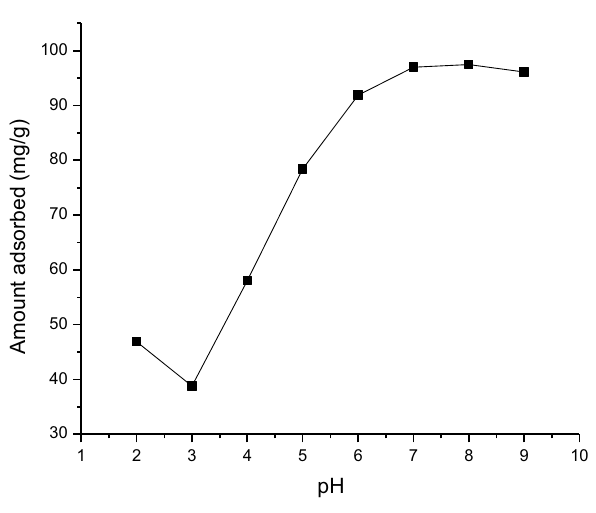
Fig. 6 Effect of adsorbent mass on adsorption of Pb 2+ ions on WM- Fe 3 O 3 O 4